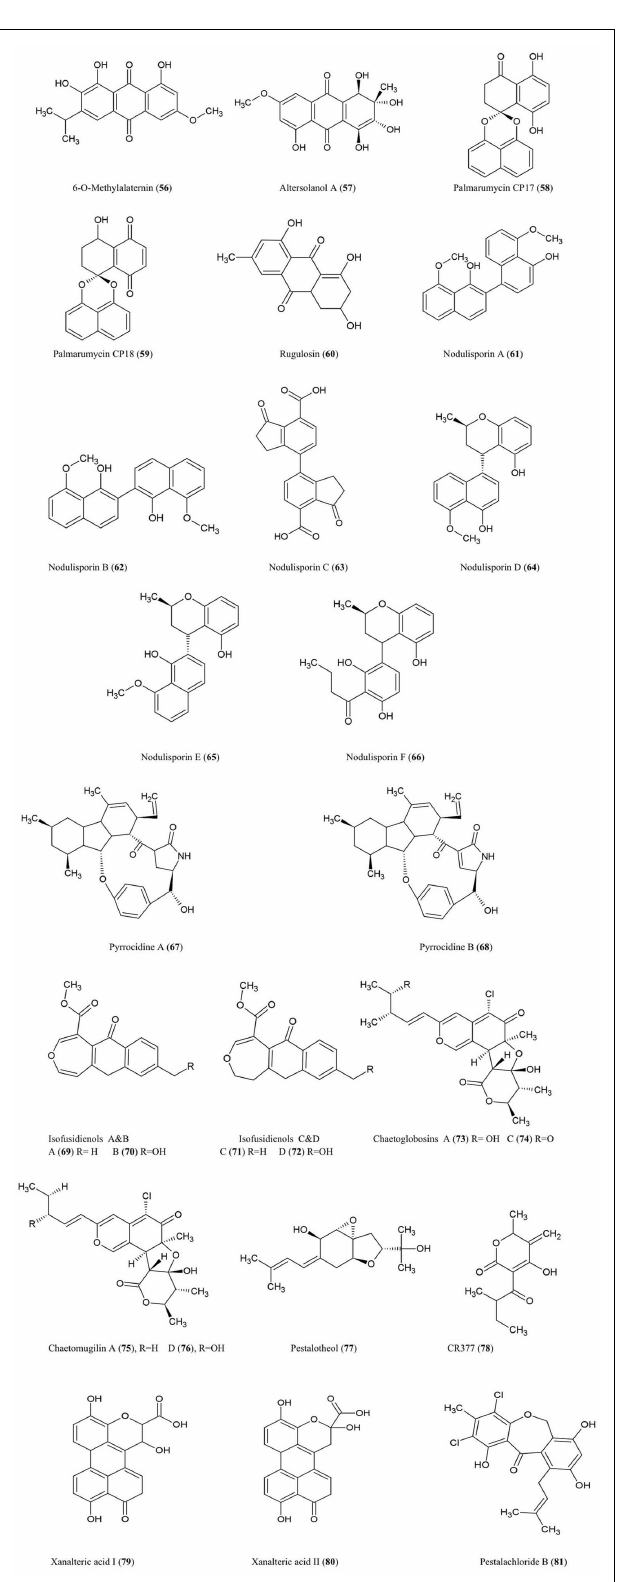
FIGURE 7 | Structures of polyketide derivatives of fungal endophyte origin